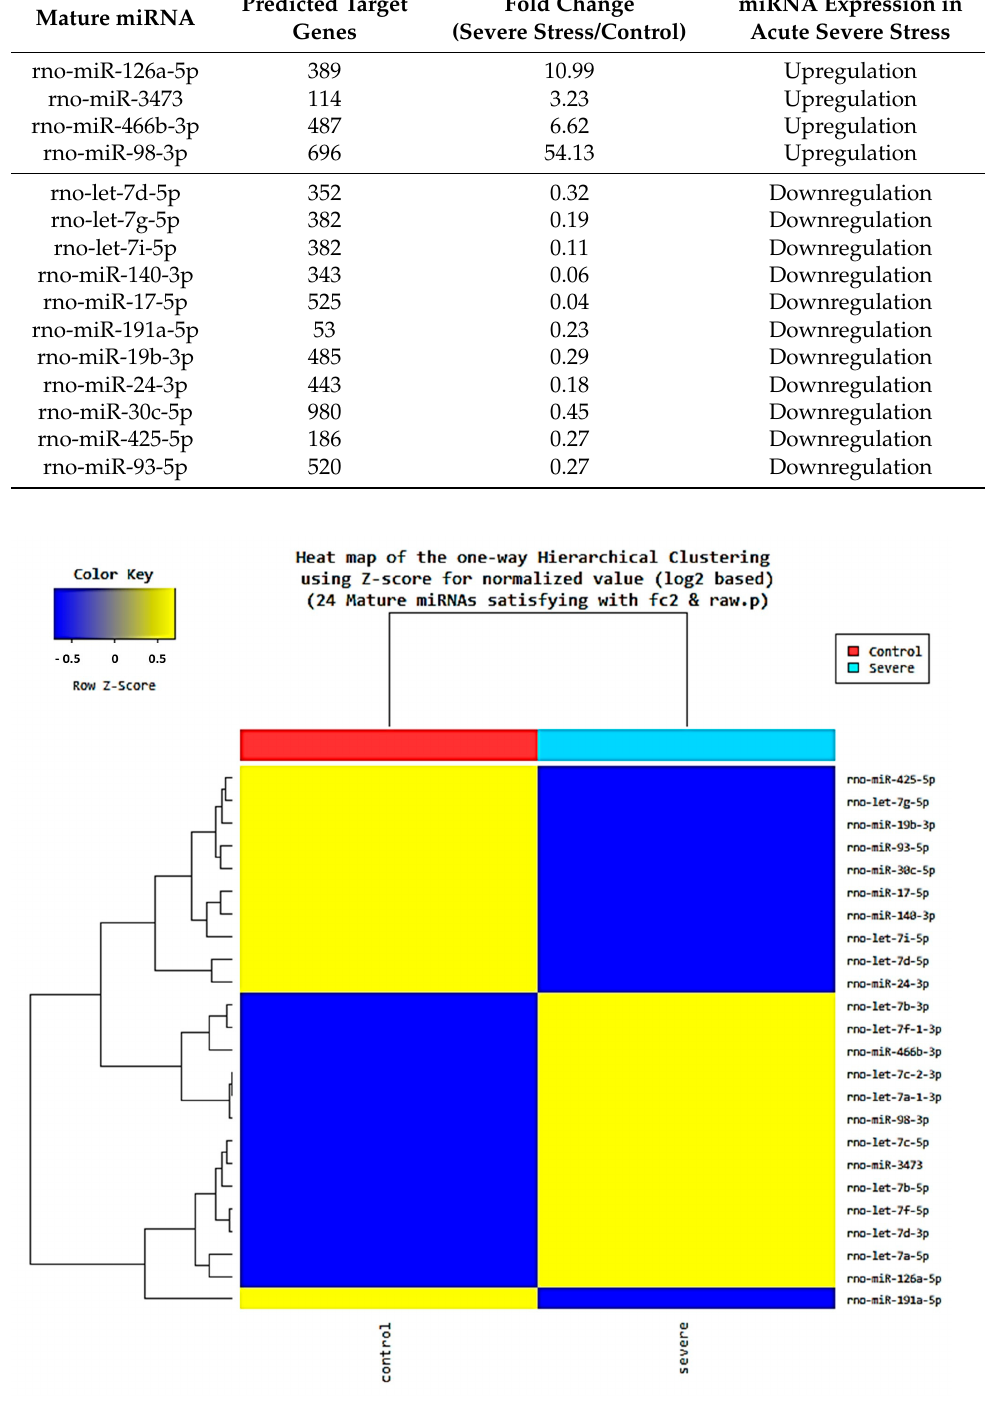
Figure 6. Heatmap of differential miRNA expression in neuronal exosomes (nEVs) induced by acute severe stress. In total, 13 miRNAs were upregulated and 11 miRNAs were downregulated in the Day 7 group compared with the control